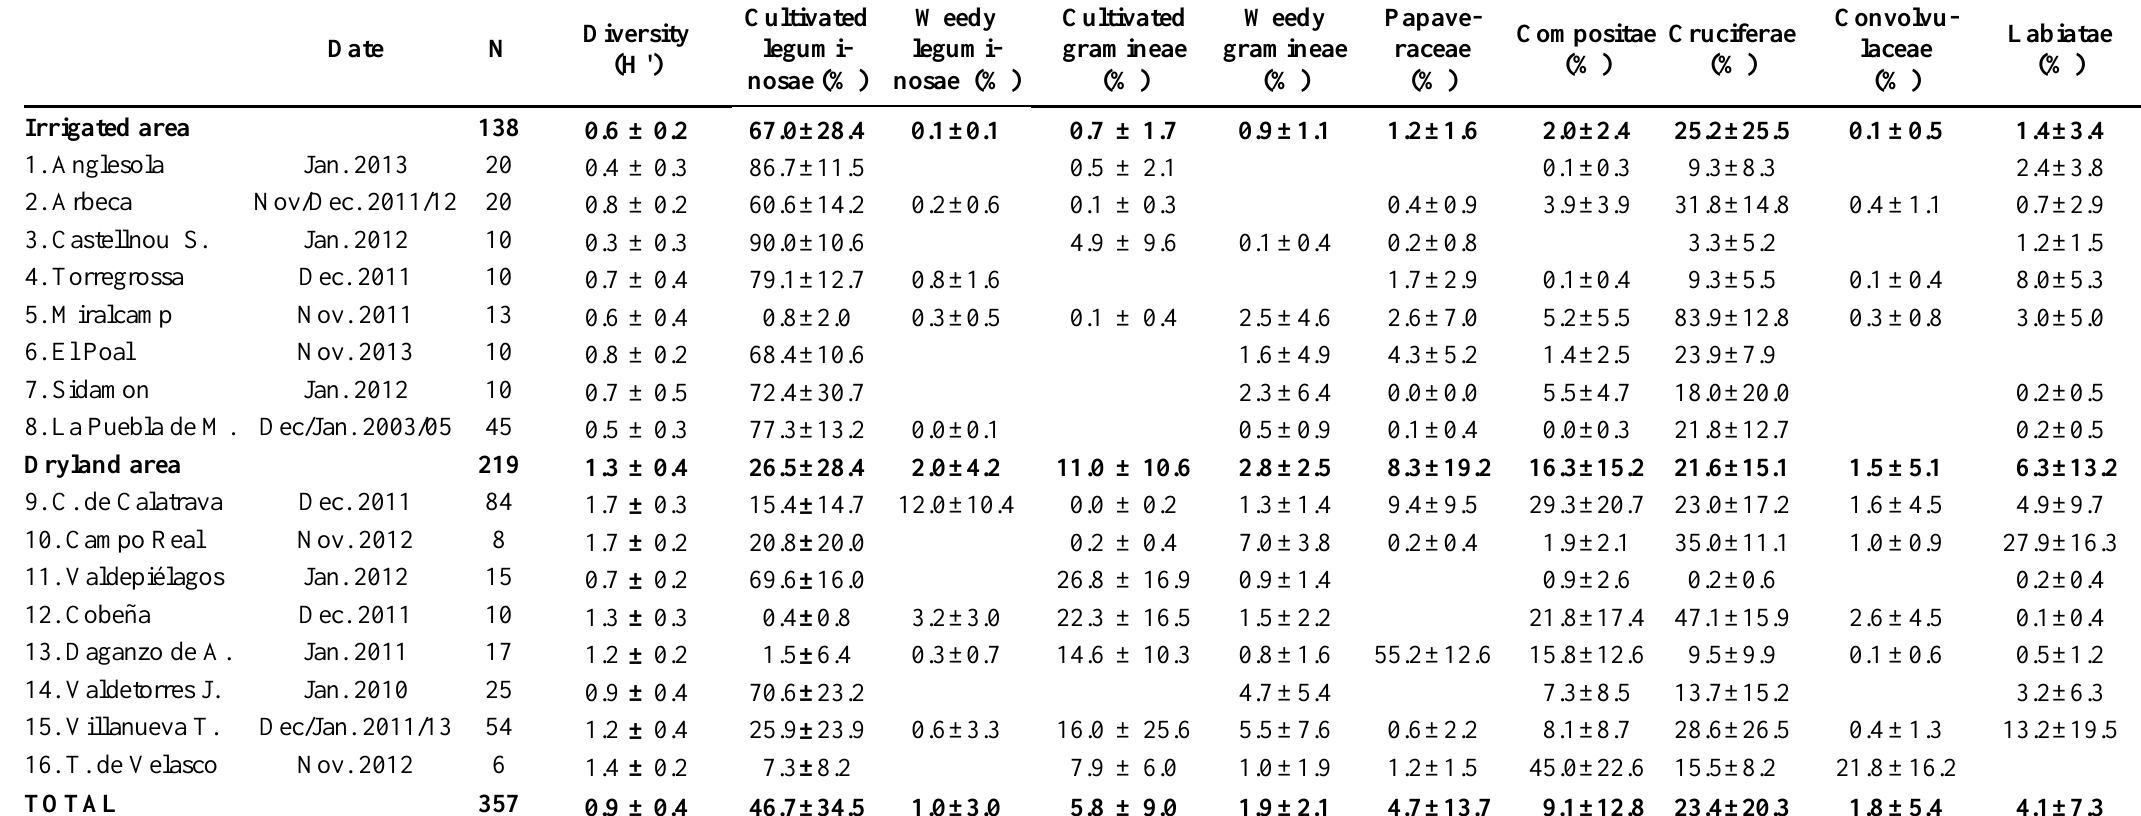
Table A1. 1. Diet diversity (H') and green plant families identified in Little Bustard diet sorted by irrigated and dry farmland area. Diet composition is shown as the average (±SD) percentage of microscope fields with presence of each family per dropping. Infrequent families (Caryophyllaceae, Boraginaceae, Dipsacaceae, Euphorbiaceae, Malvaceae, Plantaginaceae, Primulaceae, Resedaceae, Rubiaceae, Scrophulariaceae) are grouped in "other" category. N represents the total number of collected droppings and Date represents date of